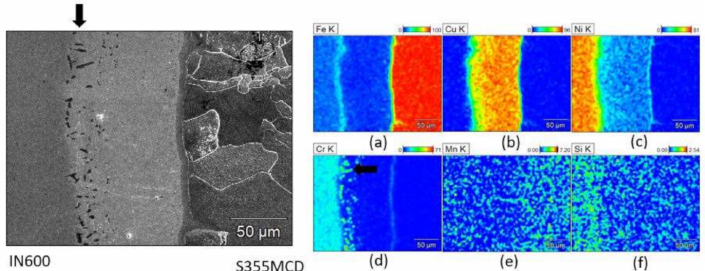
Figure 8. Micrographs of the structure and composition in weight % of the S355MCD-IN600 joint area: ( a ) iron ( b ) copper ( c ) nickel ( d ) chromium ( e ) manganese ( f )